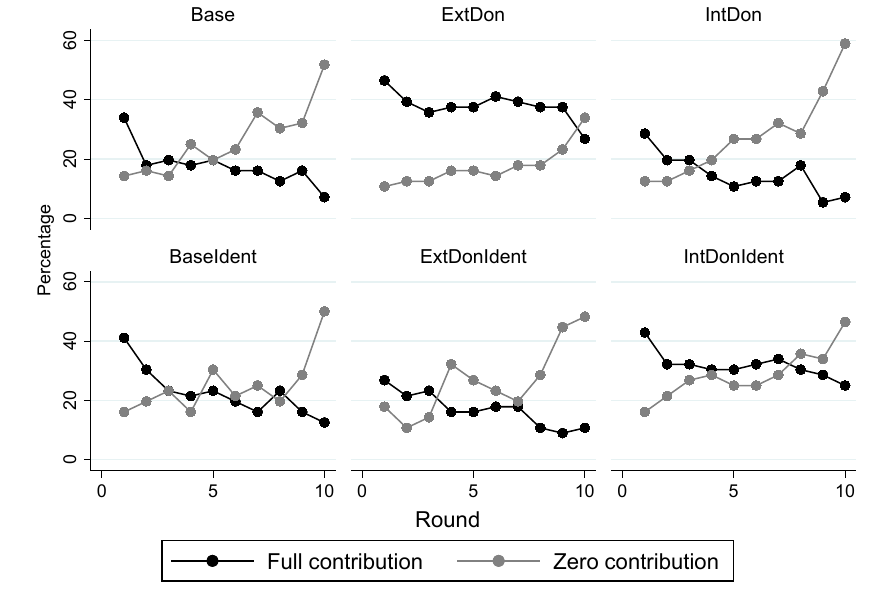
Figure 4. Percentage of full/zero contributors.